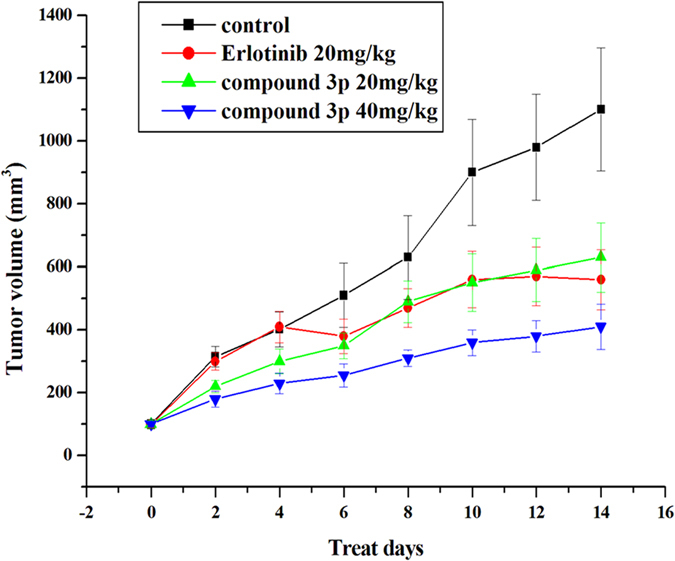
The tumor volumes in mice treated with saline, Erlotinib, compound 3p (20 mg/kg) and compound 3p (40 mg/kg).